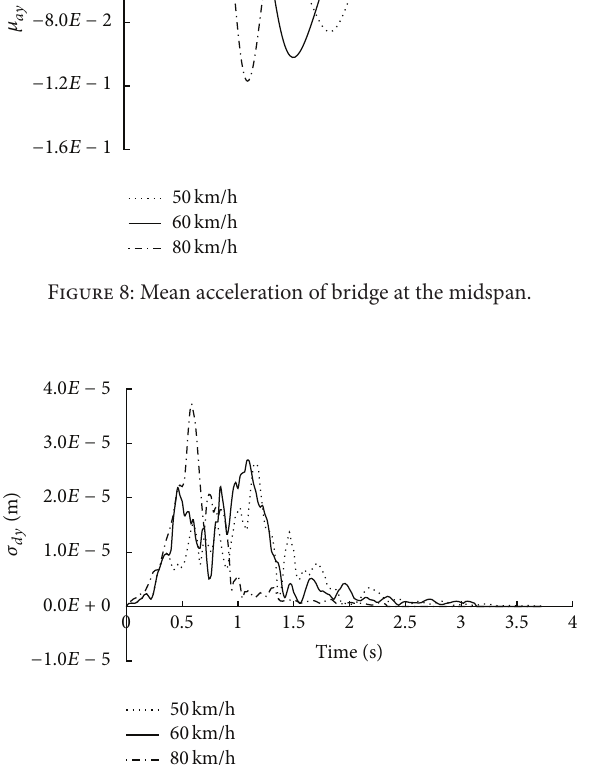
Figure 9: Standard deviation of bridge midspan